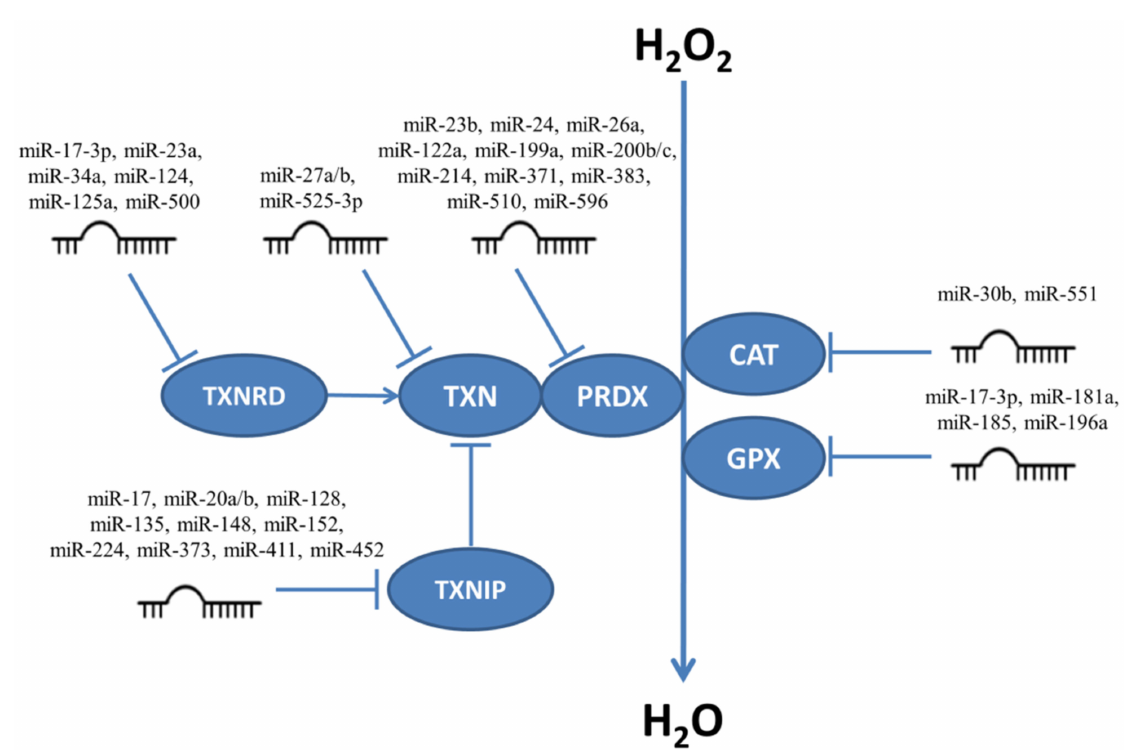
5. MiRNAs Participating in Regulation of H 2 O 2 Level